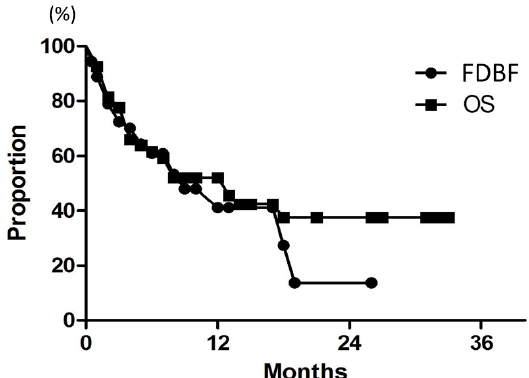
Figure 3. Curves for FDBF and OS for all 54 patients.